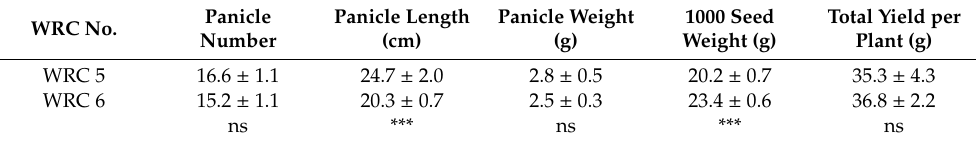
Table 1. Yield-related traits in WRC 5 and WRC 6. Data are shown as the mean ± SD of 5–10 replicates. Data with asterisks indicate a significant di ff erence between WRC 5 and WRC 6 (Student’s t -test, *** p < 0.001). WRC